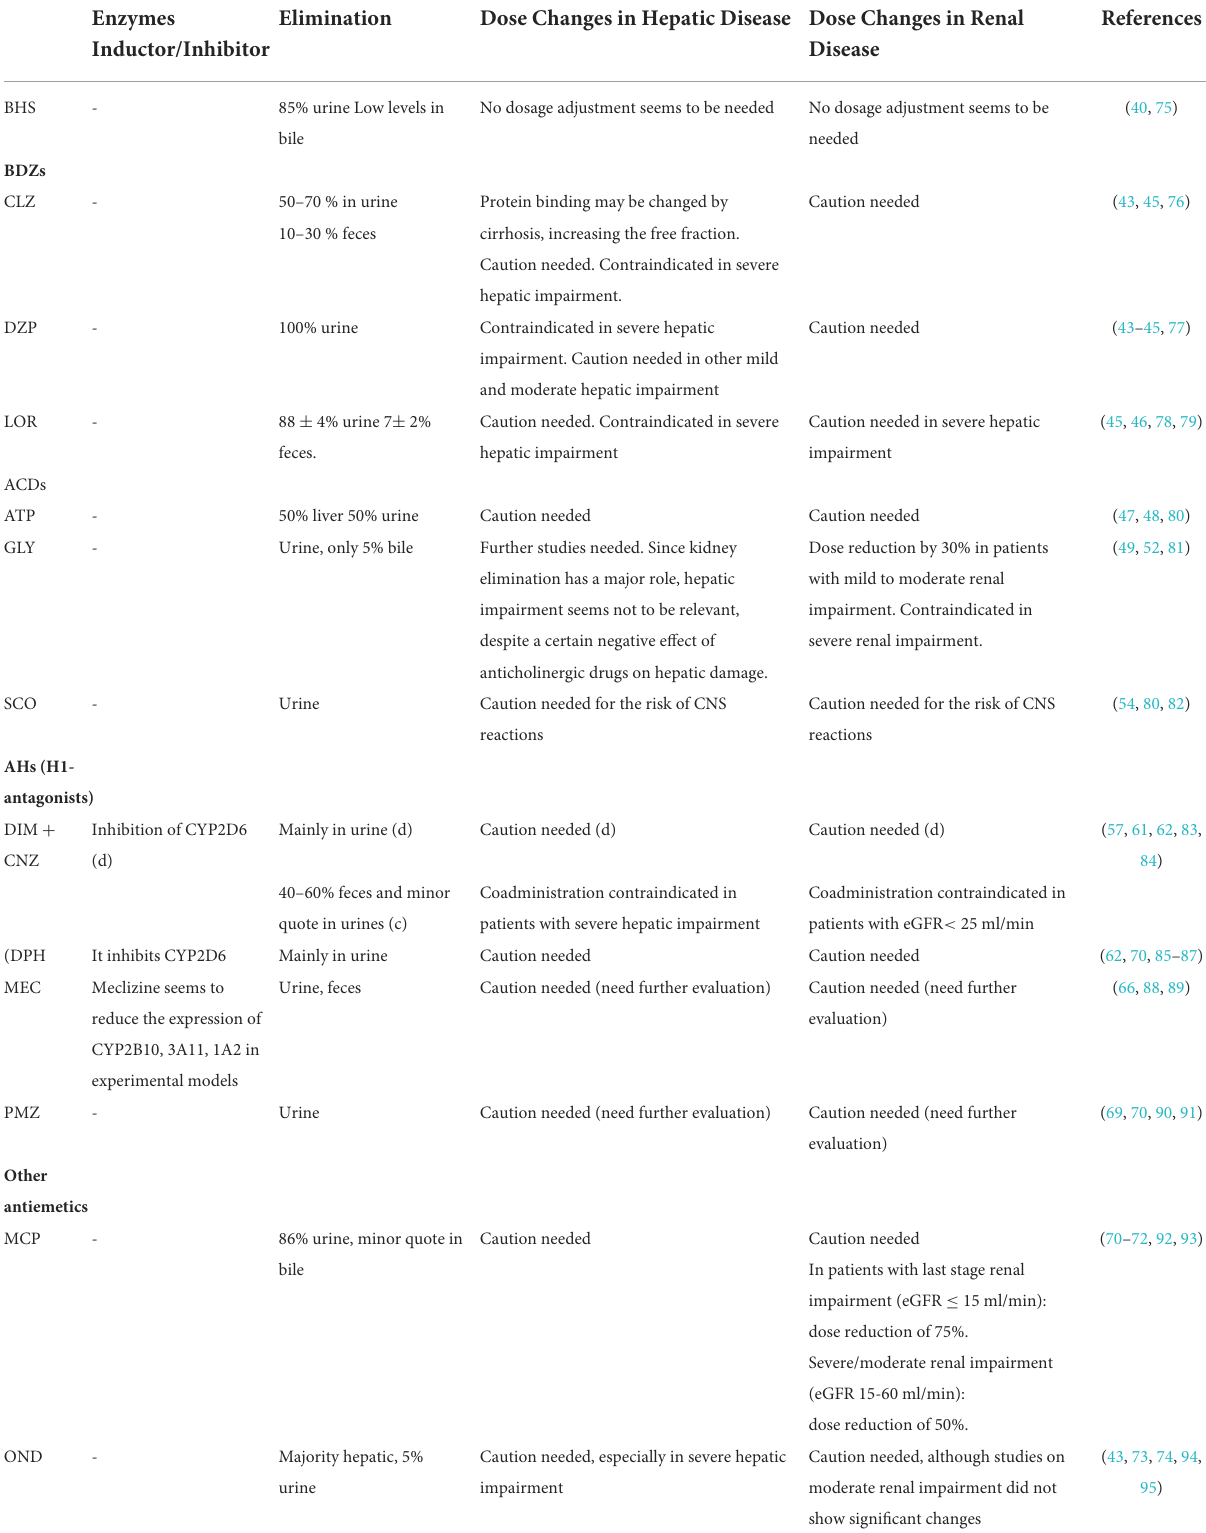
TABLE 3 Pharmacokinetics of drugs used in peripheral vestibular vertigo (part II).